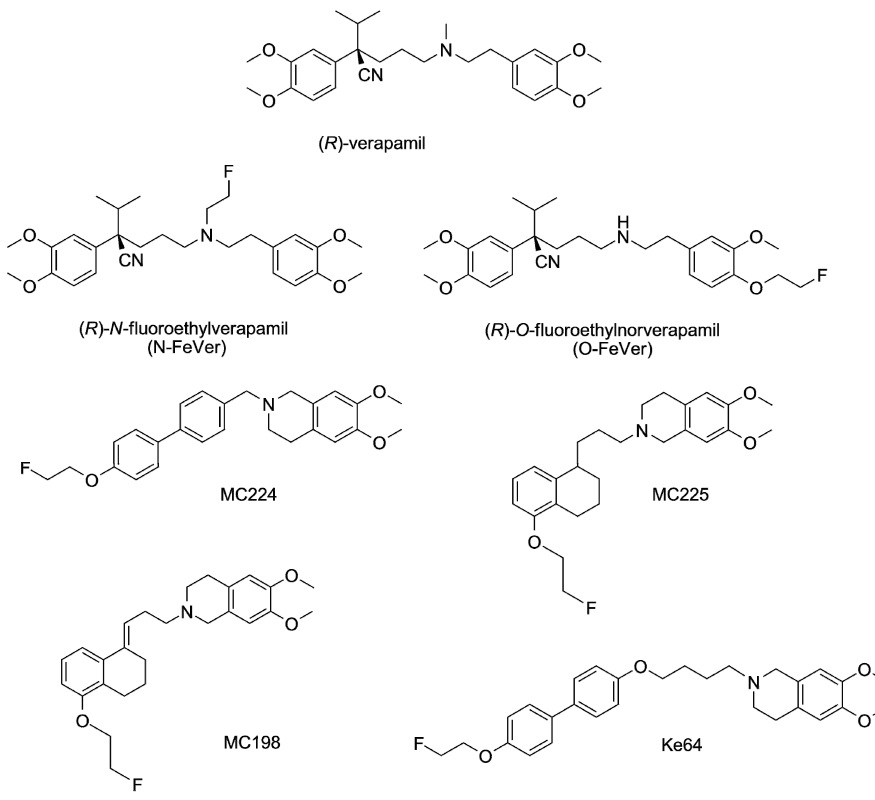
Figure 1. Chemical structures of all test compounds.